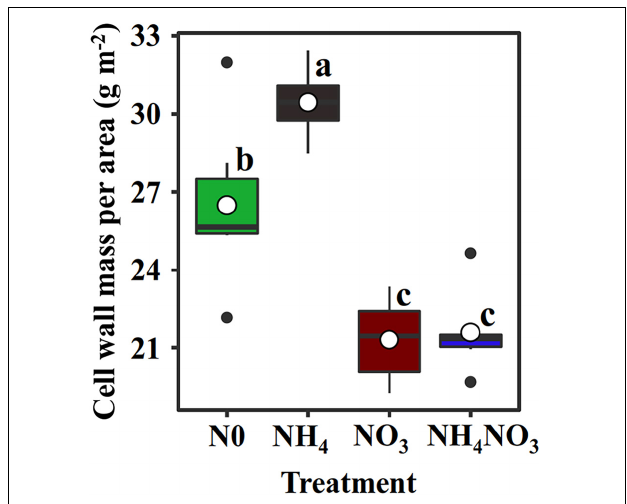
FIGURE 5 | Effect of N forms treatments on cell wall mass per area in L. chinensis . White dot is “Mean”; black dot is “Outlier”; horizontal is “Median”; the top of vertical line is “Max” and the bottom of vertical line is “Min.” Different lower-case letters indicate significant differences under N0, NH 4 , NO 3 , and NH 4 NO 3 treatments ( p < 0.05) ( n = 6).